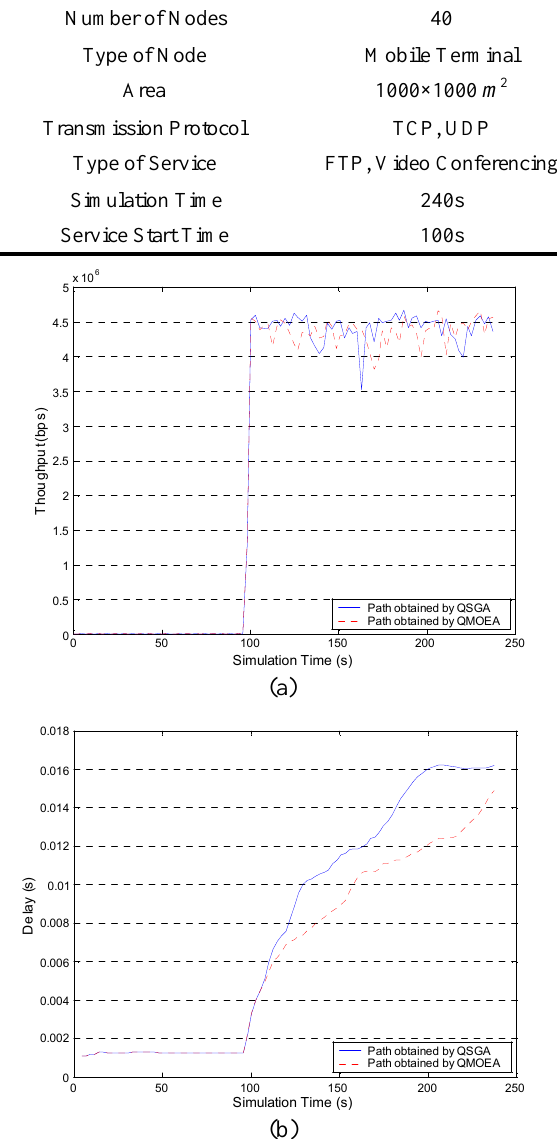
Fig. 9 Comparison ofperformance between two paths when MANET is running with FTP service Fig. 9 is the comparison of performance between QMOEA and QSGA with FTP service. The data drop curve is not given herein because FTP uses TCP to transmit data to ensure the number of data drop to be zero. The graph indicates that the throughput of two paths obtained by QSGA and QMOEA are almost the same (see Fig. 9(a)), meanwhile the path gained